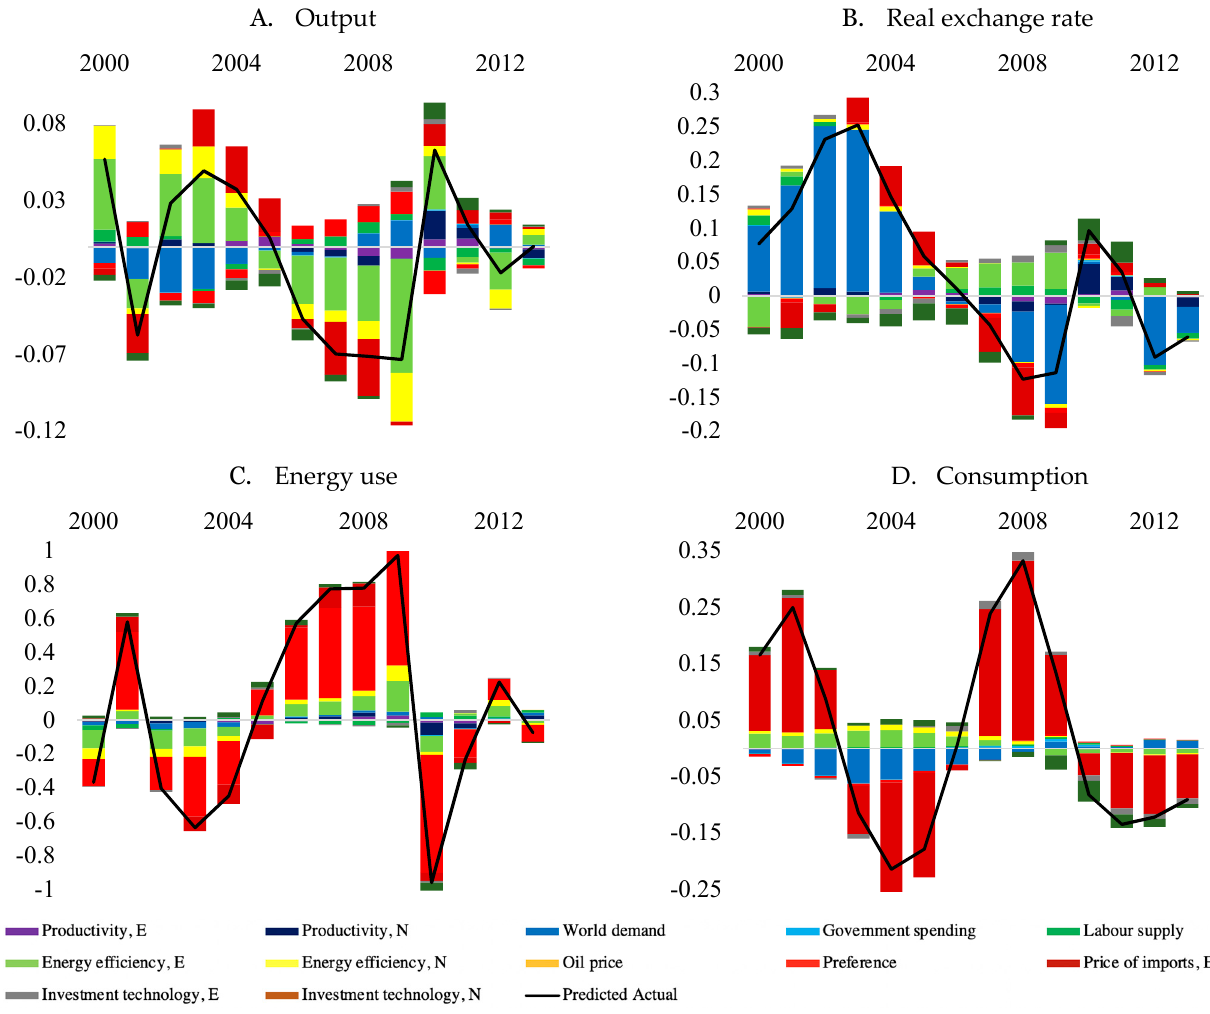
Figure 5. Historical decompositions of macro variables in the VAR.